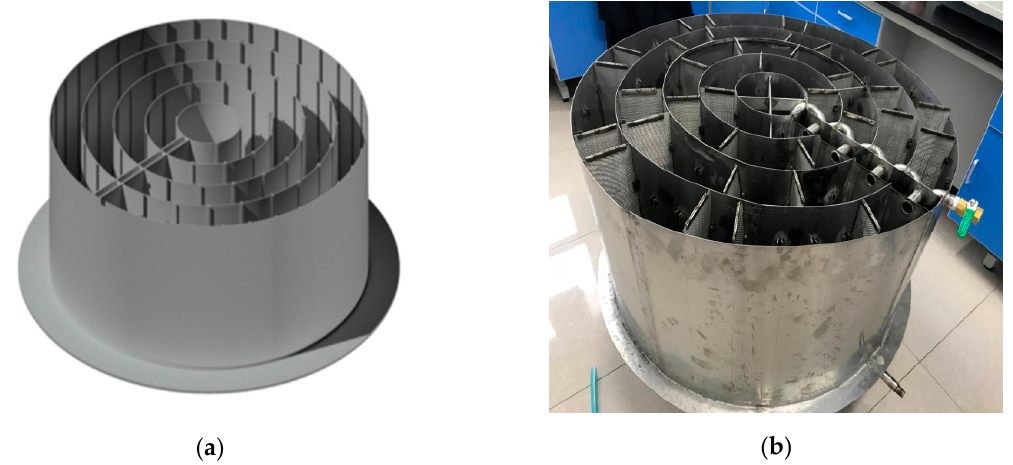
Figure 1. ( a ) The concentric circular diversion wall adsorption reactor schematic; ( b ) the concentric circular diversion wall adsorption reactor.